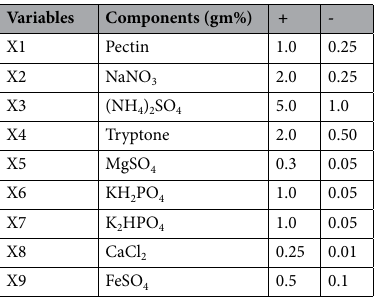
Table 1. Media components and their levels for the Plackett–Burman